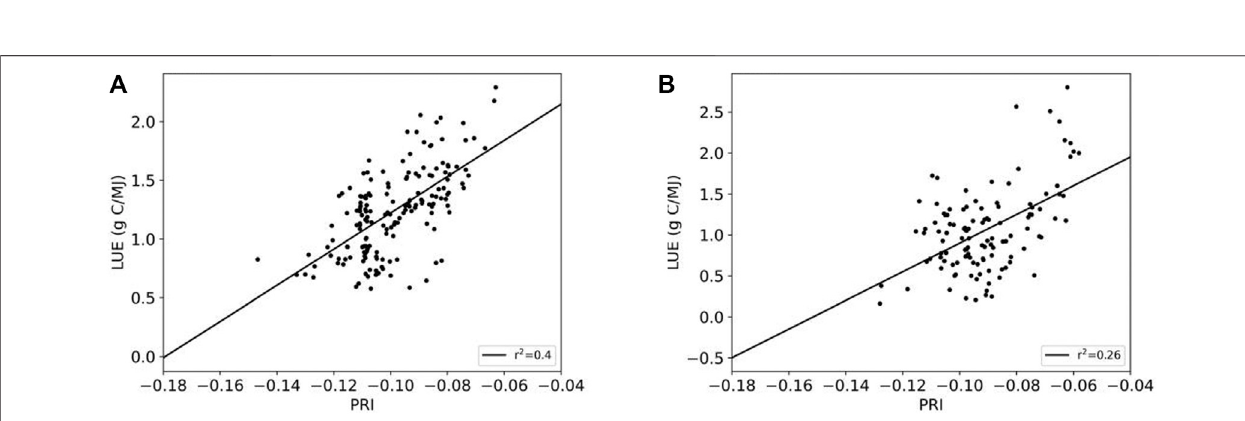
Frontiers in Earth Science |